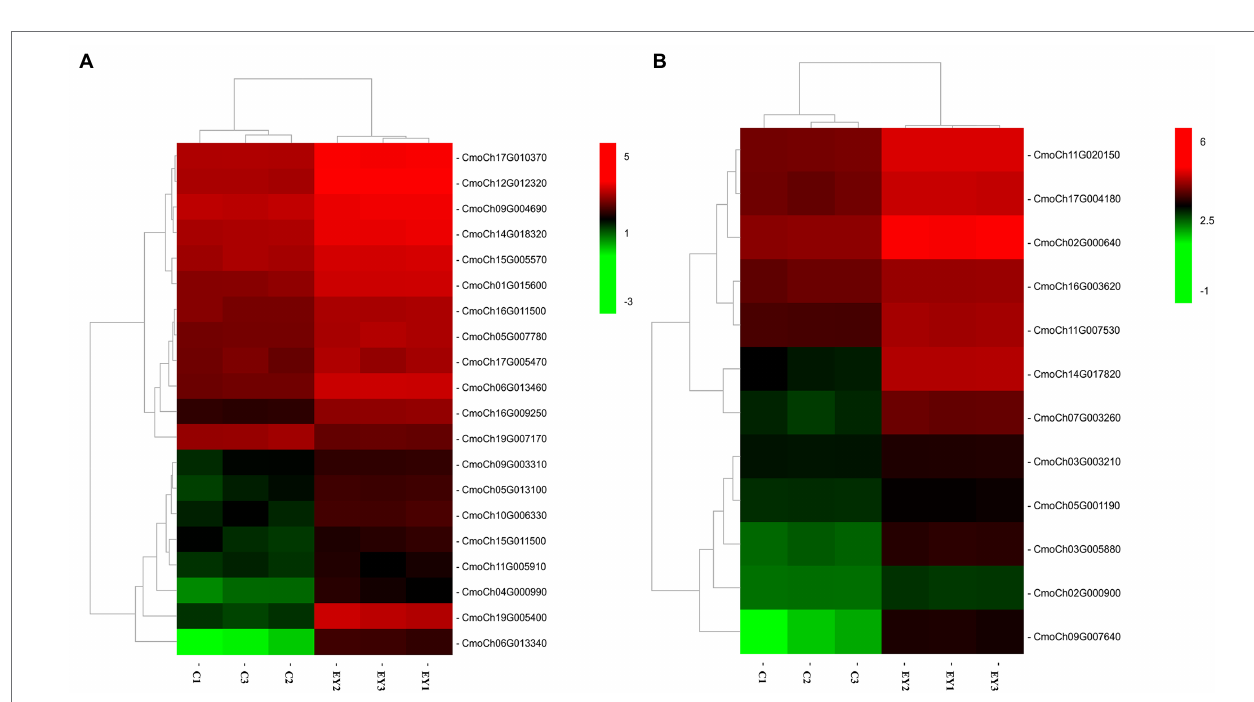
FIGURE 4 | Kyoto encyclopedia of genes and genomes (KEGG) enrichment analysis of DEGs.